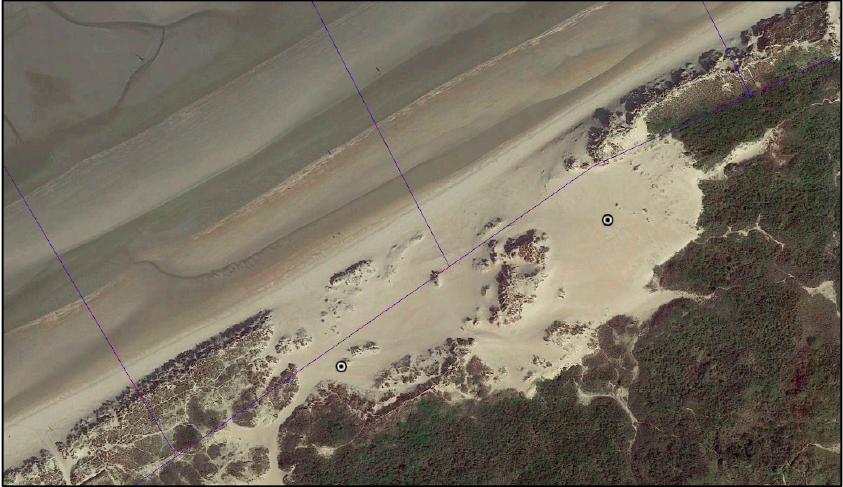
Figure 15. Dune blowouts at sections 36 to 38.